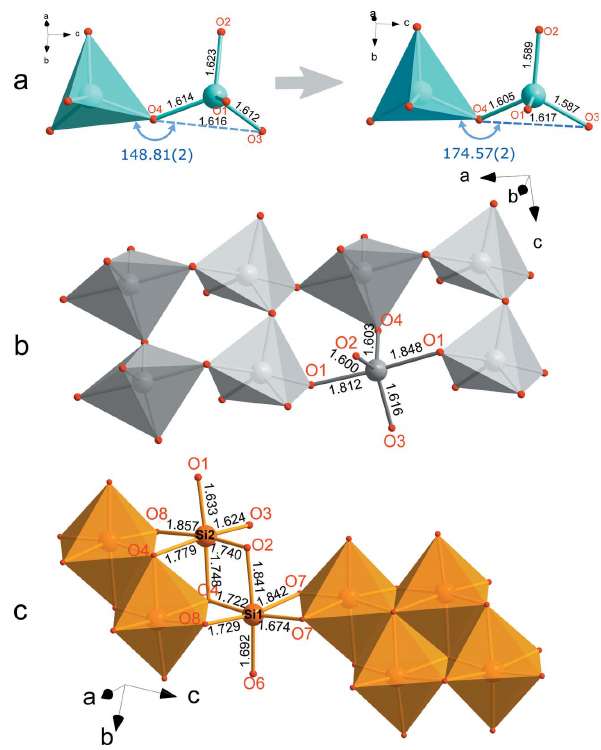
Figure 3 The evolution of silicon-based structural units along the high-pressure treatment of danburite. ( a ) Distortion of an Si 2 O 7 ditetrahedral group from 1.1 (1) to 22.6 (1) GPa. Note the respective increase in the O3— O4—O3 angle from 148.81 (2) to 174.57 (2) (cid:3) that causes the anomalous enlargement of the c axis along the compression. ( b ) A chain built of SiO 5 trigonal bipyramids in the structure of danburite-II ( Pnam ) at 25.4 (1) GPa. ( c ) A chain built of edge-sharing SiO 6 octahedra in danburite-III ( P 1) at 25.4 (1) GPa. The Si—O bond distances are given in